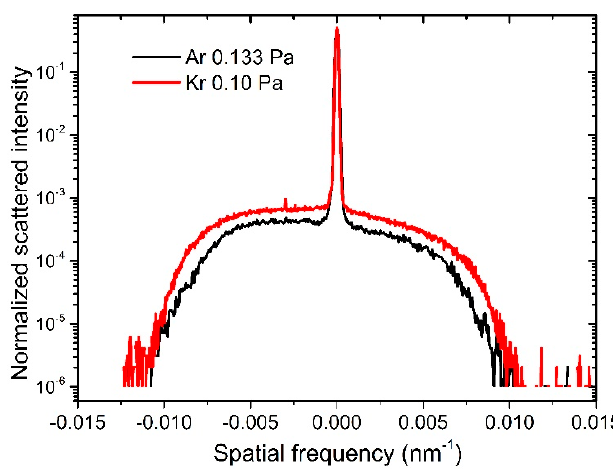
Figure 4. Rocking curve measurements of the 150-bilayer samples sputtered by two gases.